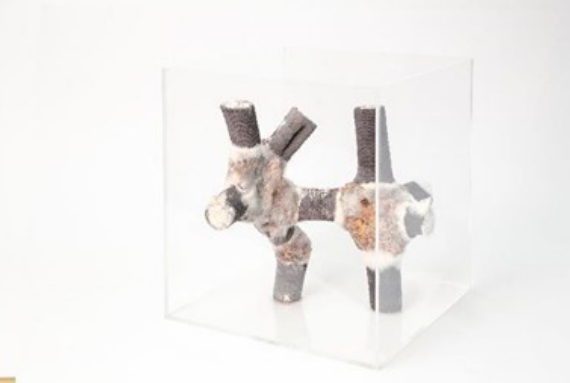
Figure 4. The Bar-node Structure Fabricated with Mycera (Image credit: Julian Jauk, Hana Vasatko, Lukas Gosch).